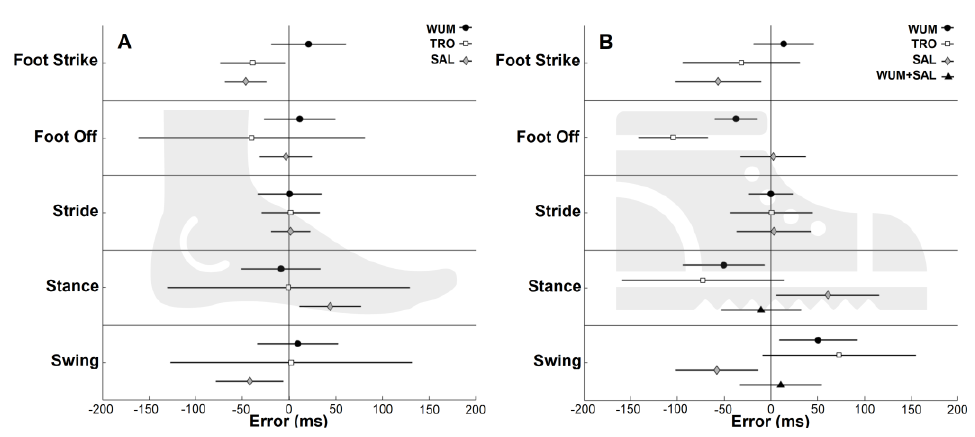
Figure 5. Biases of WUM (black circle), TRO (white square), and SAL (grey diamond) with limits of agreements (horizontal black lines) for gait events identification and gait temporal parameters: ( A ) barefoot condition (left) and ( B ) shoed condition (right). To optimize stance/swing estimation, mixed solutions were also tested. The combination improving results is reported (biases are repre- sented as black triangles) for stance and swing duration in a shoed condition. These were estimated identifying FSs with WUM and FOs with SAL.